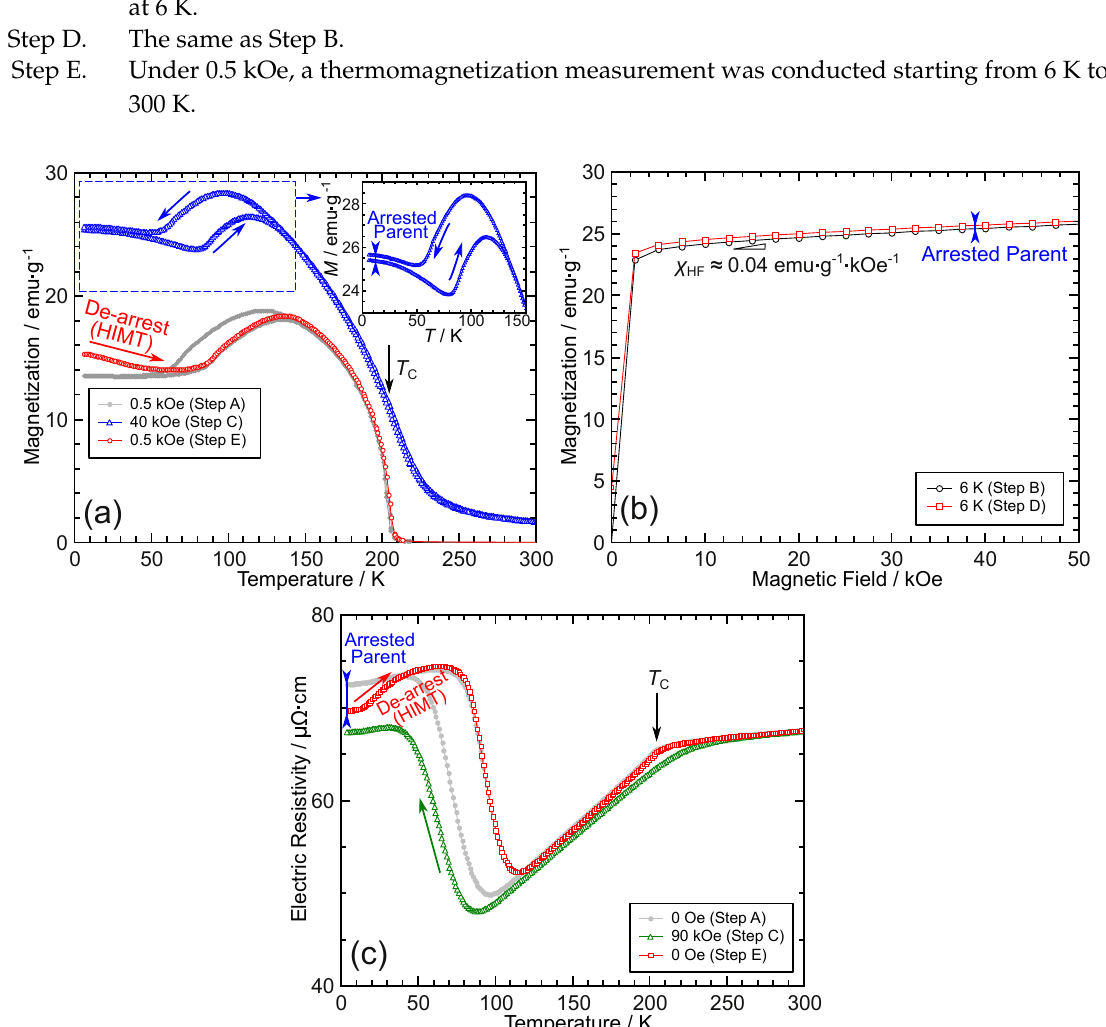
Figure 4. ( a ) Thermomagnetization, ( b ) magnetization, and ( b ) electric resistivity measurements intended for the observation of the thermal transformation arrest (TTA) phenomenon. The de-arrest behavior, where the heating-induced martensitic transformation (HIMT) occurs, was observed in both ( a ) and ( c ). Refer to the text for the details and the definitions of Steps A to E. In ( b ), χ HF denotes the high-field magnetic susceptibility of the martensite